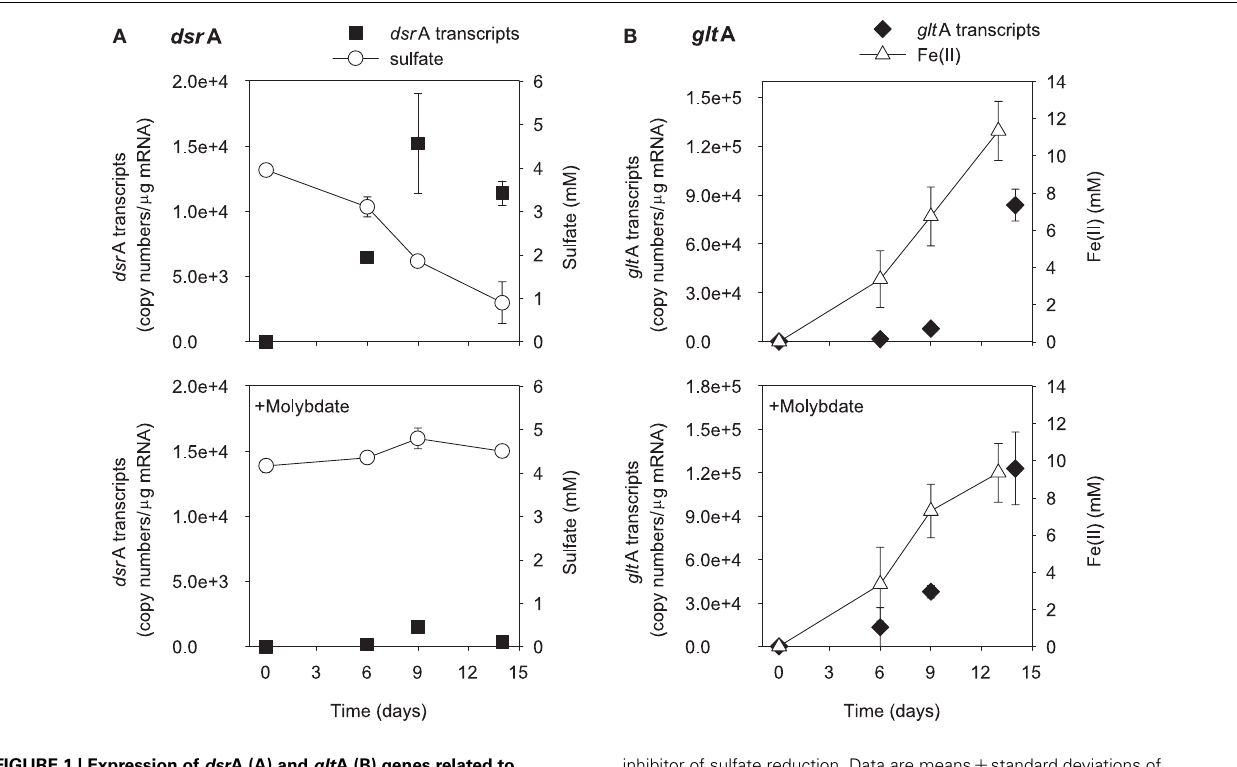
FIGURE 1 | Expression of dsr A (A) and glt A (B) genes related to electron acceptor reduction in ethanol-biostimulated microcosms. The lower panels show treatments amended with molybdate as an